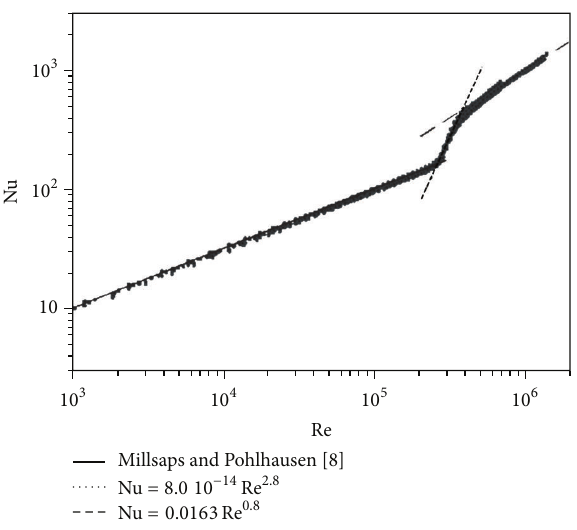
Figure 6: Nusselt number Nu versus Reynolds number Re for a rotating disk. From Cardone et al. [6].